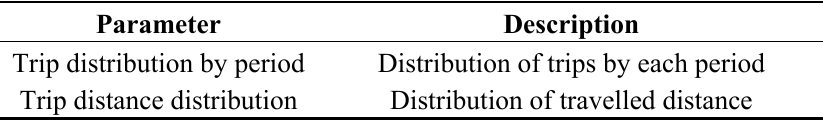
Table 3. EVeSSi trip